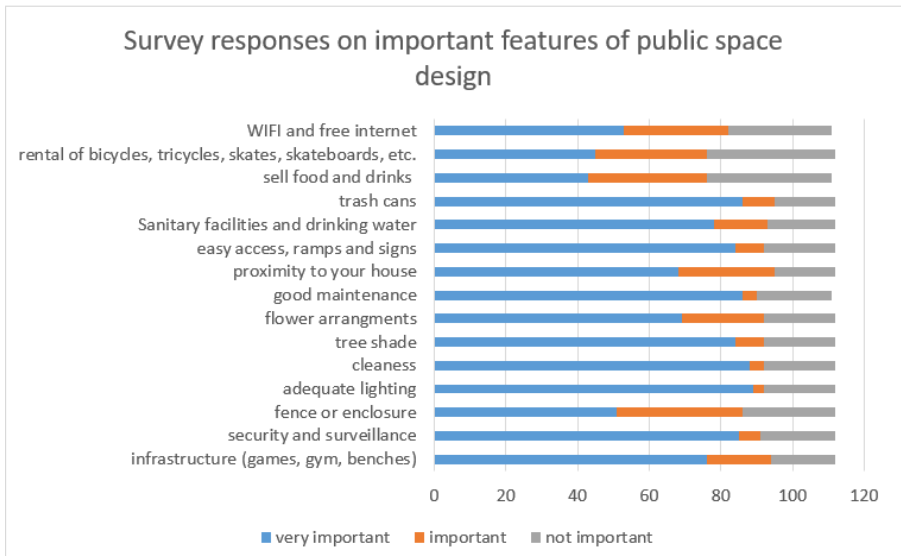
Figure 3. Analysis of survey results.